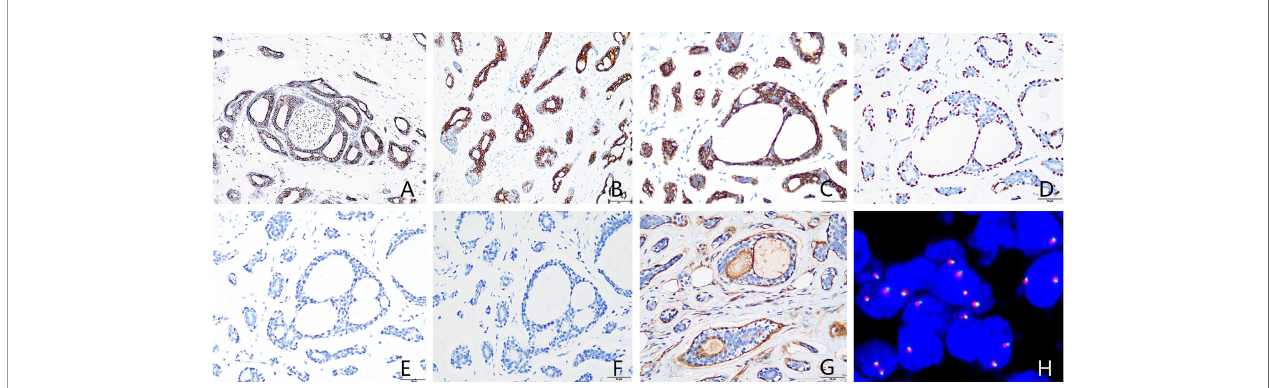
FIGURE 2 | Immunohistochemical staining and MYB gene detection. (A) Epithelial cells were CD117-positive. (B) Epithelial cells were CK7-positive. (C) Basal cells were CK5/6-positive. (D) P63 highlighted intact myoepithelial cells around the acini. (E) ER was negative. (F) PR was negative. (G) Basement membrane materials were highlighted by collagen type IV staining. (H) Molecular pathology analysis by fl uorescence in situ hybridization (FISH) revealed that the tumor was negative for MYB rearrangements. [ (A – G) immunohistochemical staining, 400× magni fi cation; (H) FISH, 1000× magni fi cation]. ER, estrogen receptor; PR, progesterone receptor.